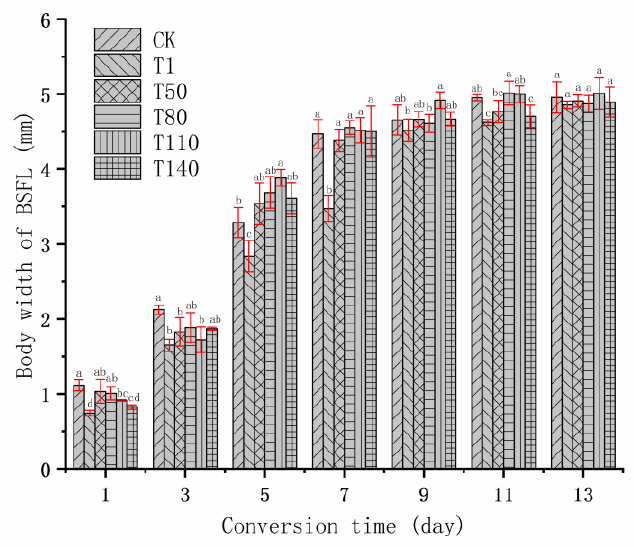
Figure 1. Trend of body length of BSFL. Note: The different lowercase letters indicate significant differences among treatments ( p < 0.05).